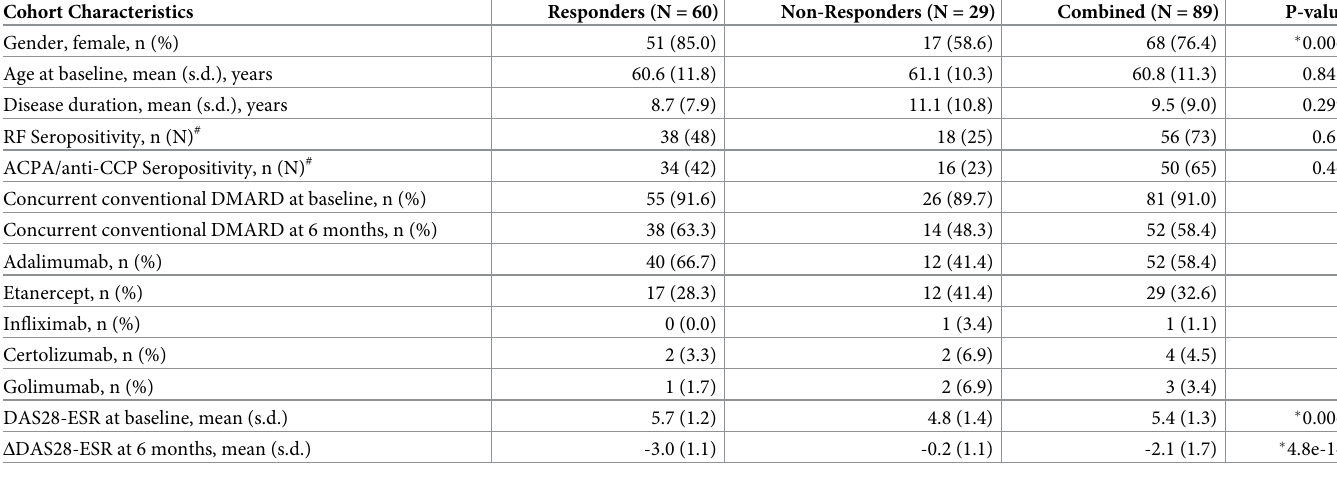
Table 1. Demographic and clinical features of rheumatoid arthritis patients. Gender and DAS values (both at baseline and 6 months) were found to be statistically sig- nificant between responders and non-responders. RF = Rheumatoid Factor, ACPA = Anti-citrullinated protein/peptide antibody, Anti-CCP = Anti-cyclic citrullinated peptides, DMARD = Disease-modifying antirheumatic drugs and DAS28-ESR = Disease activity score with 28-joint counts and erythrocyte sedimentation rate. Cohort